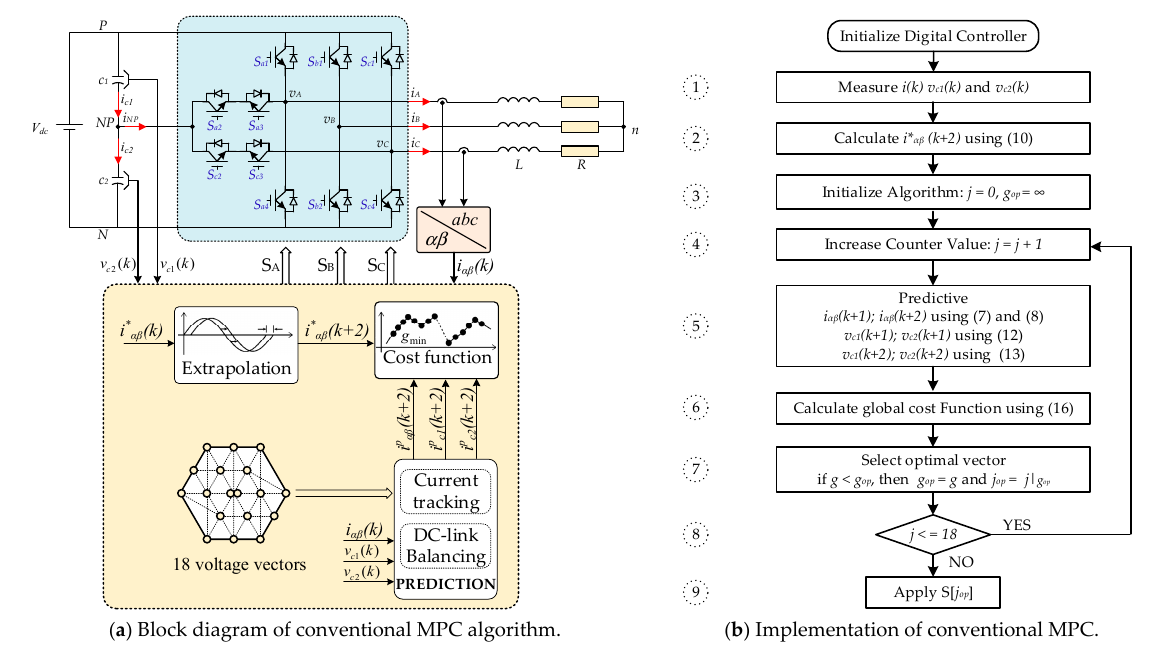
Figure 5. Normal MPC algorithm for the asymmetric T − type NPC inverter.